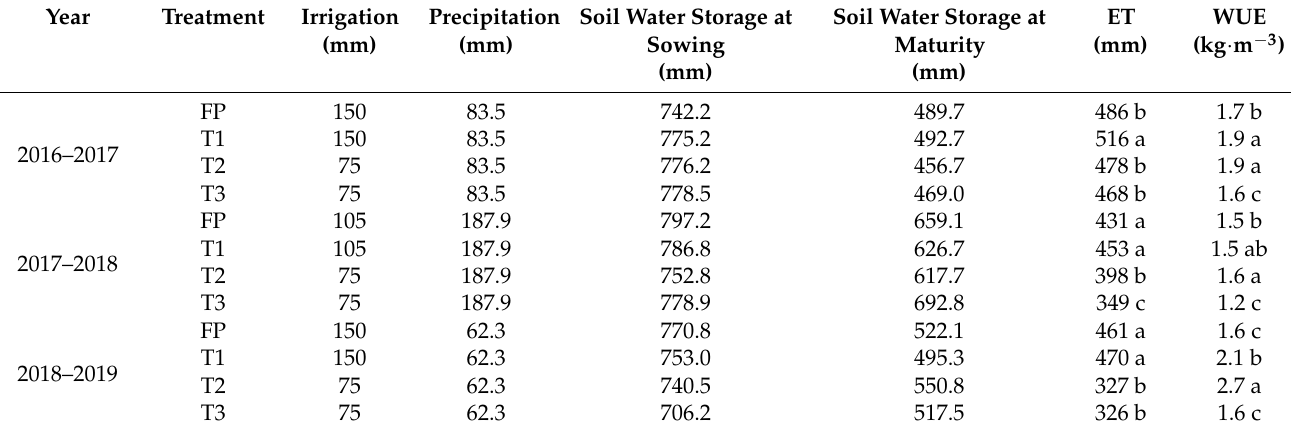
Table 5. Annual irrigation, precipitation, ∆ W, evapotranspiration (ET), and water use efficiency (WUE) under different treatments during 2016–2019 growing seasons of winter wheat. Year Treatment Irrigation